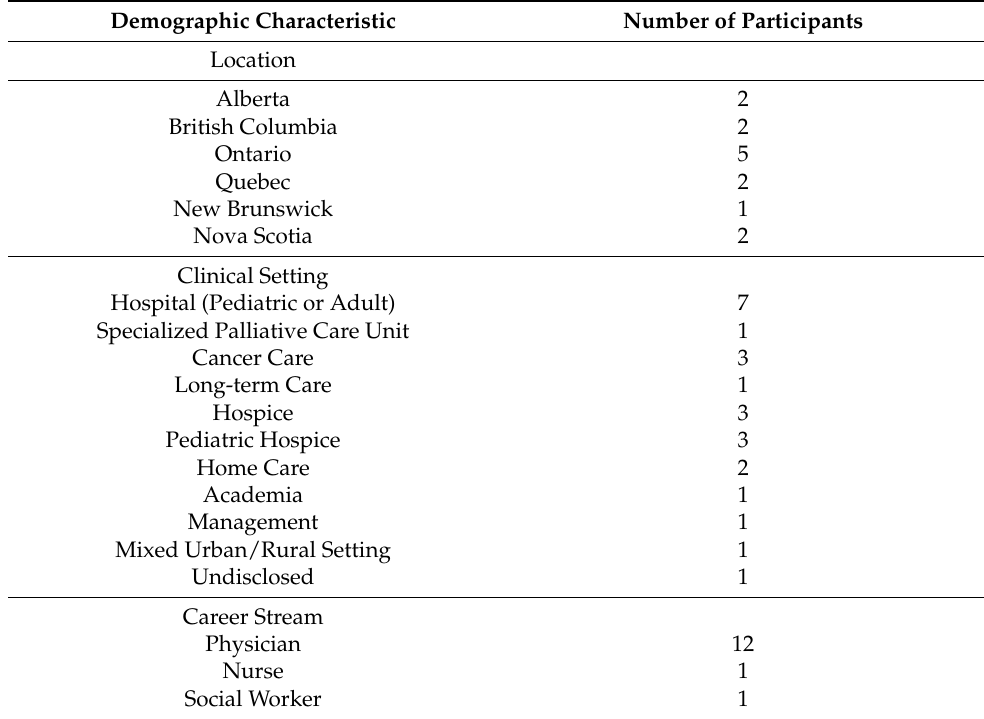
Table 1. Participant Demographic